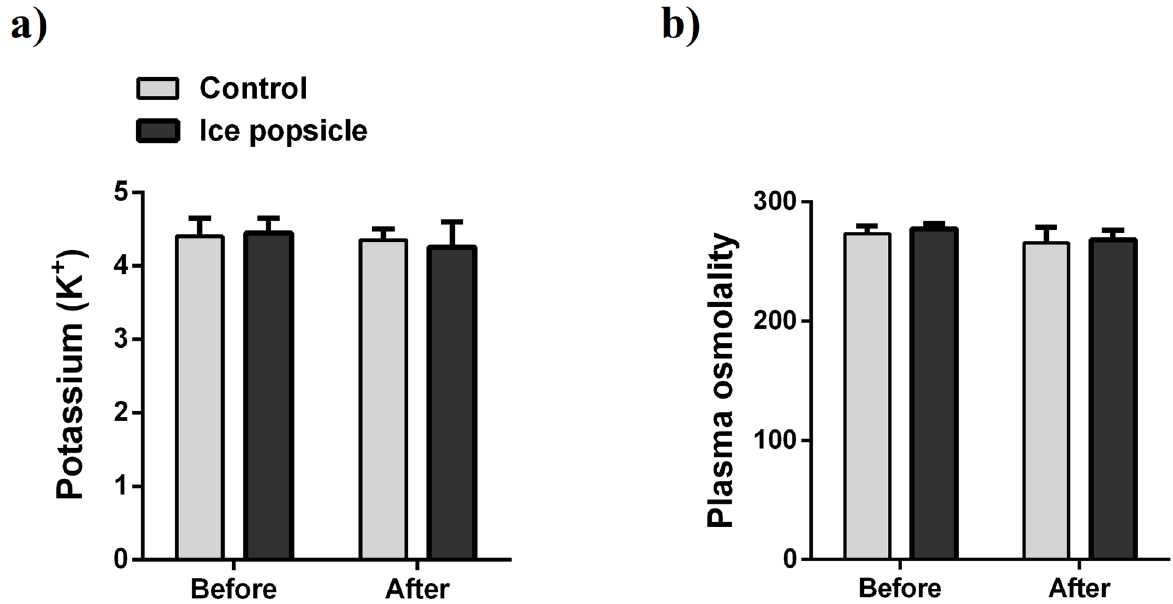
Figure 7. The levels of potassium and plasma osmolality before and post ice popsicles administration. The statistical analysis was made using two-way ANOVA